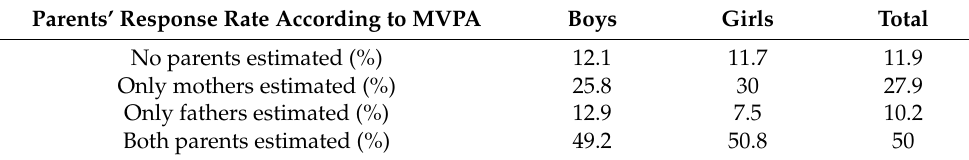
Table 1. Characteristics of parents’ estimation of their children’s MVPA response rate.